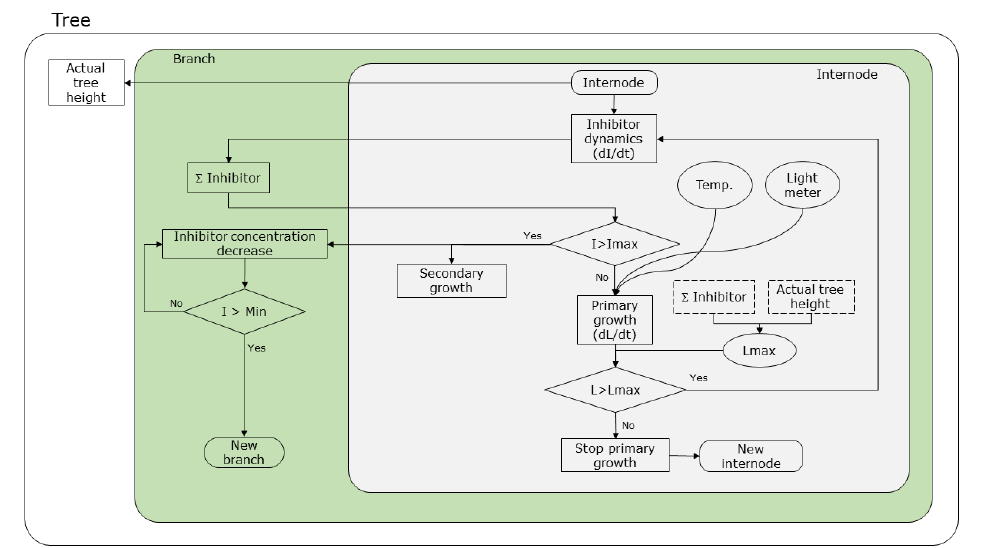
Figure 3. Proposed tree growth model scheme and relationships between modules. The blocks in the schematic represent the various functions of the modules, the rhombus blocks represent the function activation conditions ( if statements in C#